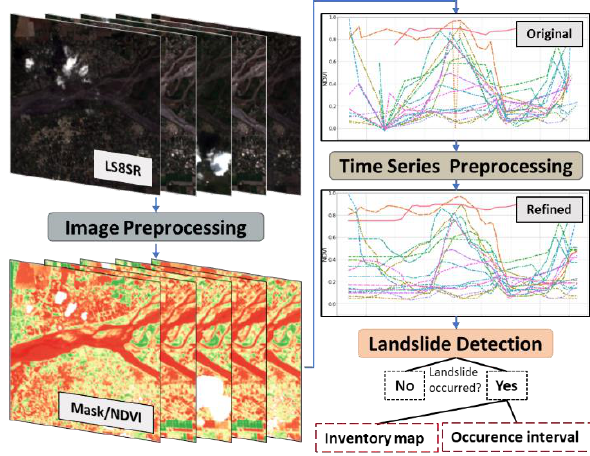
Figure 1. Workflow of the proposed method.